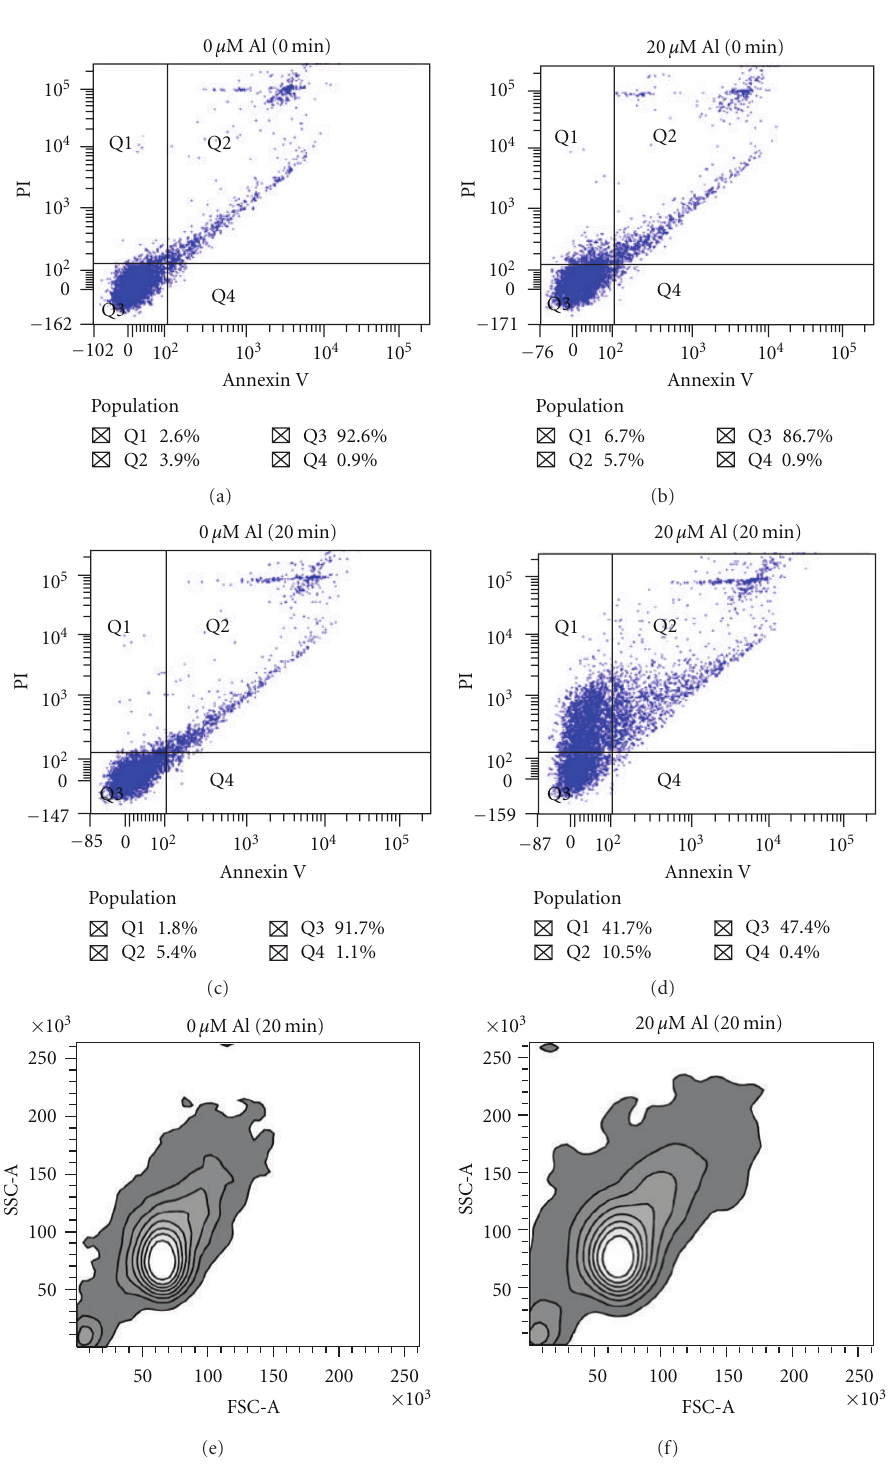
Figure 4: Thymocytes were exposed to 0 µ M (a, c) and 20 µ M (b, d) AlCl 3 at 0 and 20 minutes. Various staining patterns signify di ff erent cell populations. Region Q3 includes live cells (PI-negative and Annexin V-negative), whereas region Q4 contains apoptotic cells (PI-negative and Annexin V-positive). Dead cells are represented in Q2 region (both PI- and Annexin V-positive), while quadrant Q1 shows damaged cells (PI-positive and Annexin V-negative). Upon a 20-minute exposure to 20 µ M AlCl 3 the cell population from the Q3 region moved to Q1 region, without a clear shift to the Q4 area first. This fact indicates that thymocytes are not undergoing the apoptotic process. Contour plots (e, f) show fluorescence intensity with regard to forward scatter and side scatter in the control (e) and in the presence of 20 µ M AlCl 3 for 20 minutes (f). The increase in forward scatter on exposure to AlCl 3 is indicative of an increase in size (i.e.,